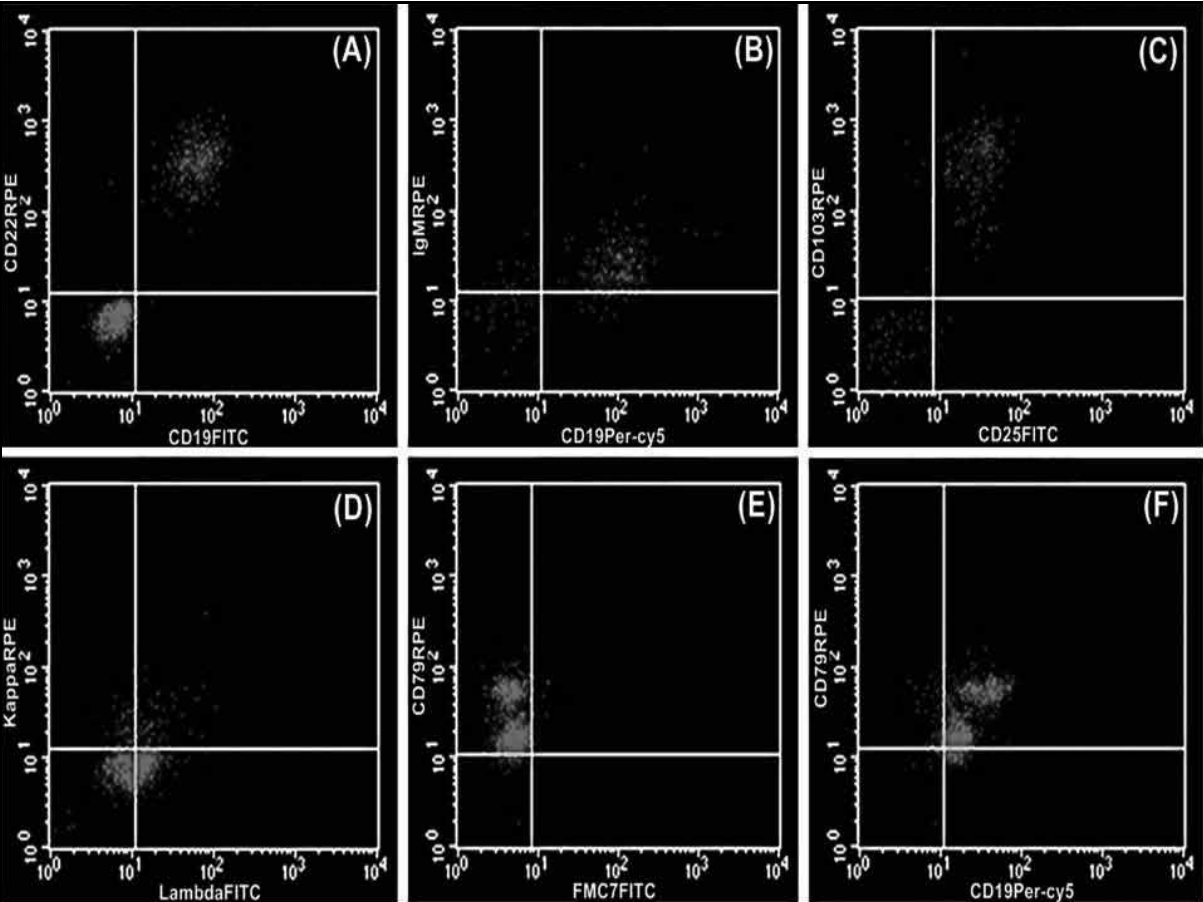
Figura – Histogramas de imunofenotipagem por citometria de fluxo com populações celulares apresentando expressões para (A) CD19 e CD22; (B) IgM e CD19; (C) CD103 e CD25; (D) Lambda, sem expressão de Kappa; (E) CD79, sem expressão de FMC7; (F) CD19 e CD79 IgM: imunoglobulina